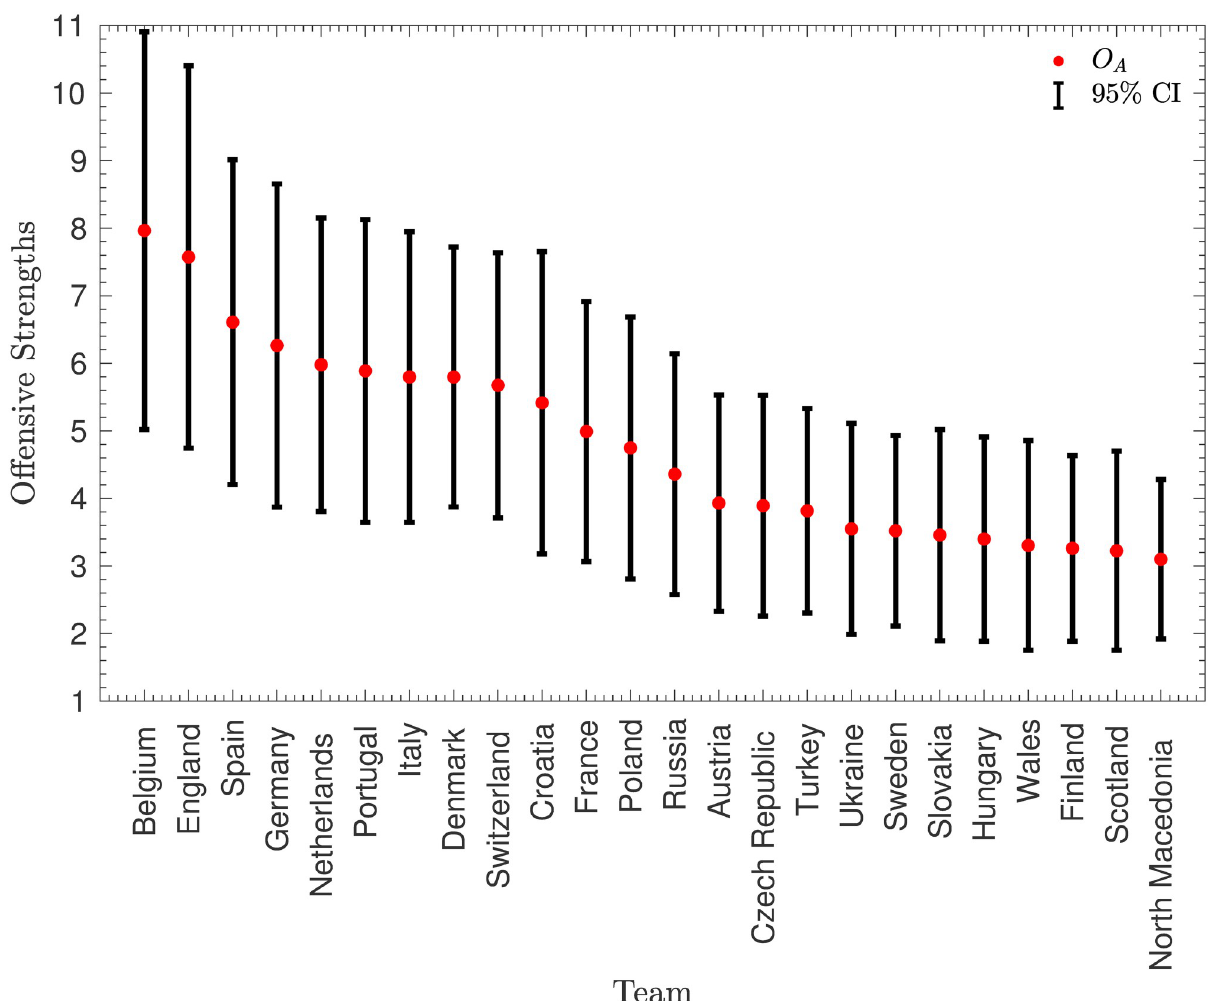
Fig 6. Confidence intervals for the O A parameters. Approximate 95% confidence intervals for the offensive strengths, O A of the teams playing in Euro